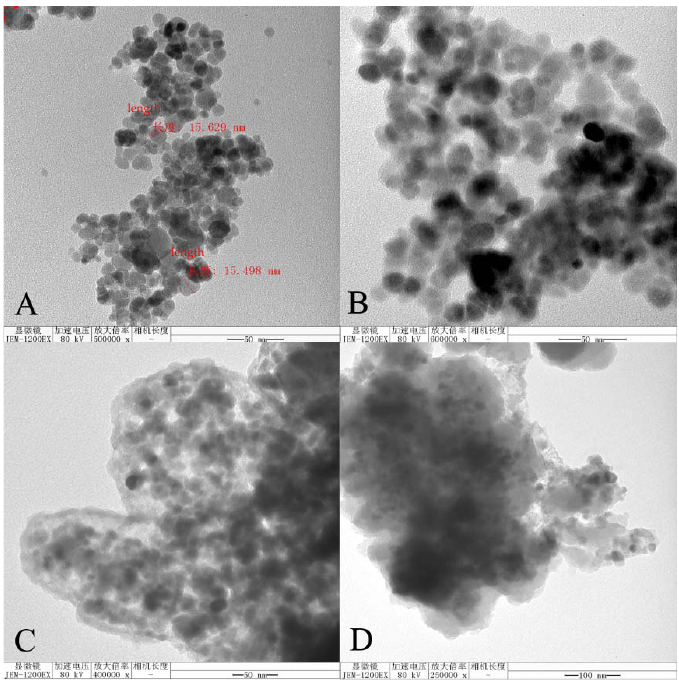
Figure 4. Transmission electron microscopes of ( A ) Fe 3 O 4 NPs, ( B ) Fe 3 O 4 @SiO 2 , ( C ) MMIPs, and ( D ) MNIPs.